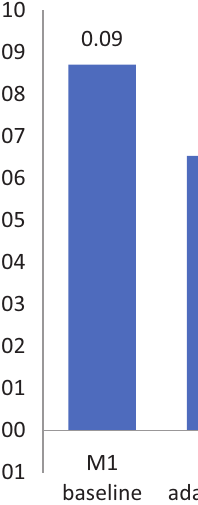
Figure 1. Dropout intentions of refugee students vs. international students (percentage‐point difference based on hier‐ archical regression models). Source: Own calculation based on the study preparation survey (WeGe). Notes: AMEs are reported. Only the effect in M1 and M2 is statistically significant; N = 954 for all models (M1–M4) with multiple imputed data; for more information on the specified models see Table 1 in Supplementary File